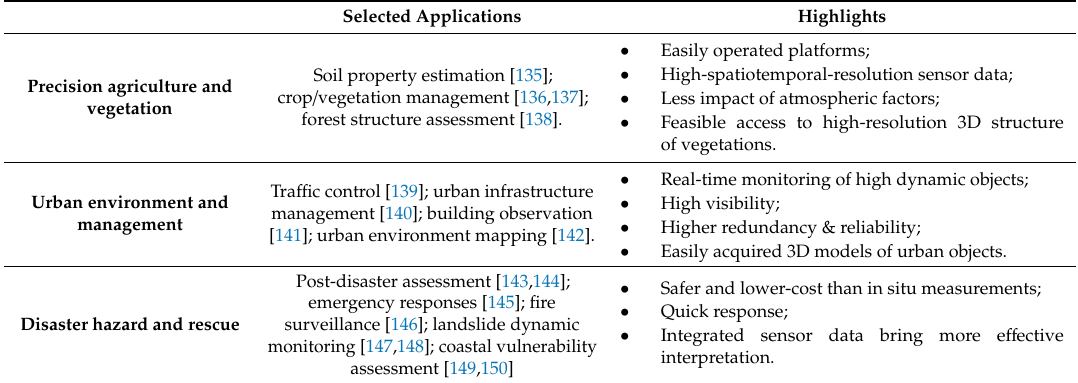
Table 3. An Overview of the selected UAVs remote sensing applications. Selected Applications Highlights Soil property estimation [135]; Precision agriculture and crop / vegetation management [136,137]; vegetation forest structure assessment